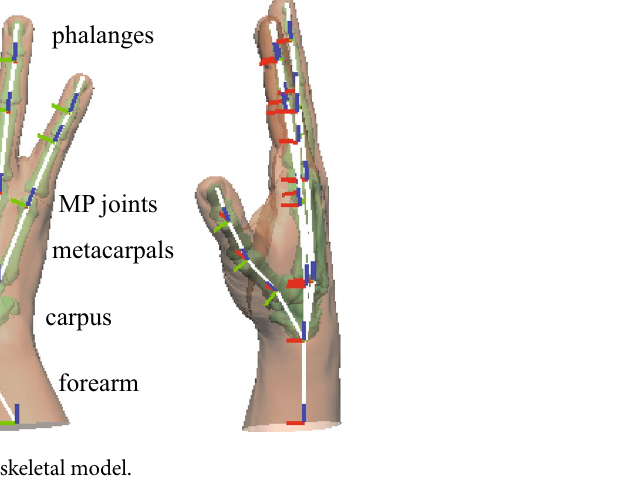
Figure 1. The hand musculoskeletal